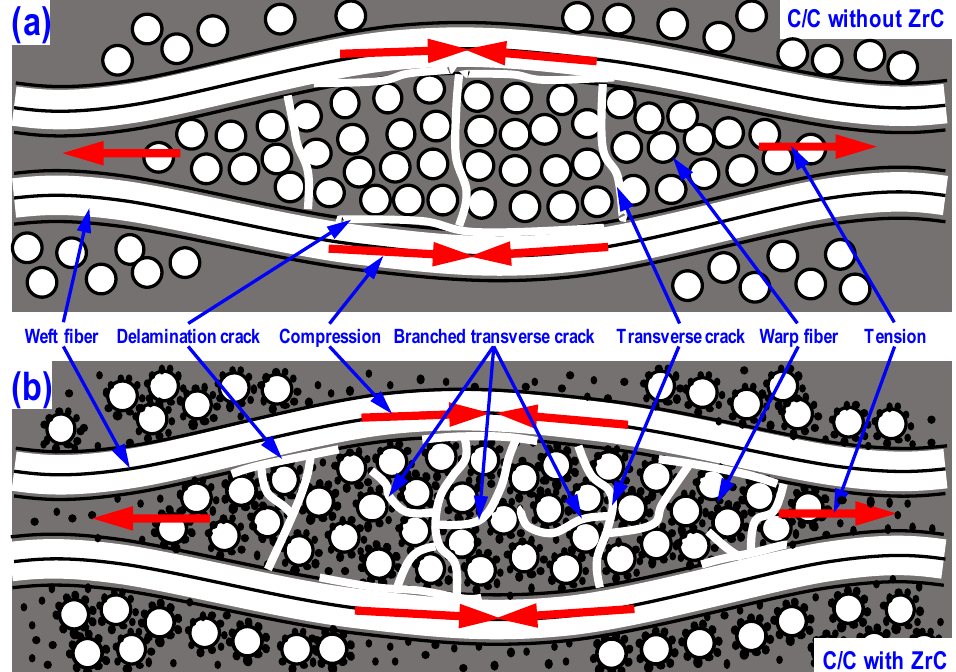
Figure 2. Formation mechanism for the porous structure of C / C: ( a ) C / C preform without ZrC nanoparticles; ( b ) C / C preform with ZrC nanoparticles.